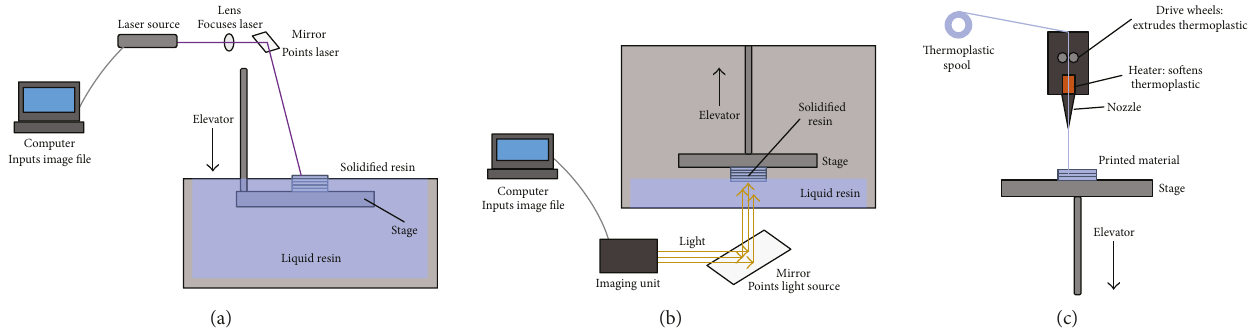
Figure 3: Schematic representation of additive manufacturing (AM) printing methods. (a) Stereolithography (SLA), (b) digital light processing (DLP), and (c) fused deposition modeling